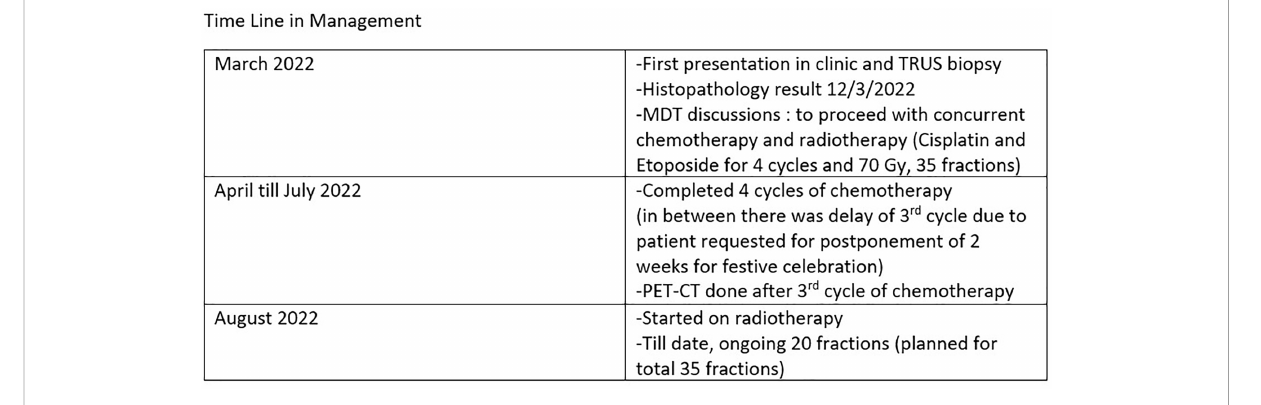
FIGURE 5 Table showing the management